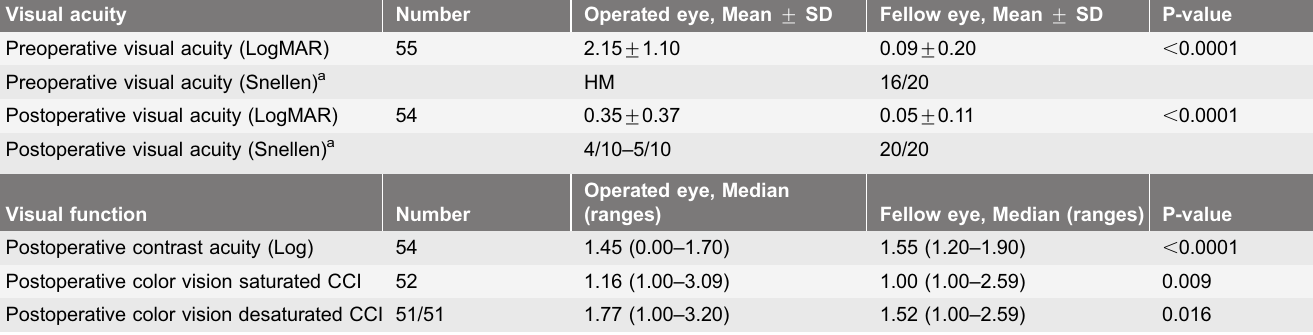
study to the results of others, because of differences in study design. Table 2. Visual function tests in operated versus in fellow control